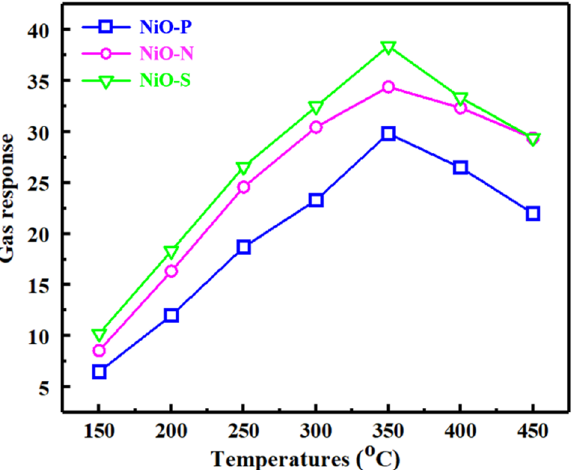
Figure 9. Gas response of NiO at 200 ppm as a function of temperature.